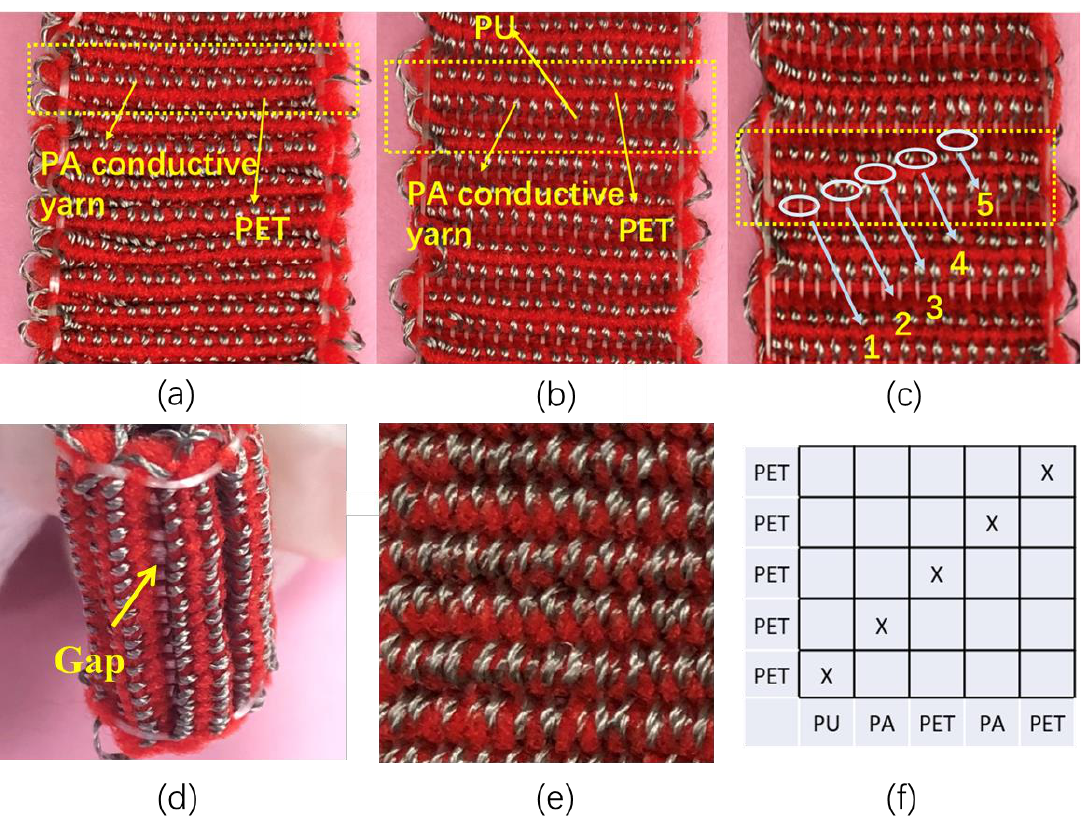
Figure 4. ( a ) The digital photograph of SWF-TENG with twill weave before stretch; ( b , c ) SWF-TENG with twill weave after stretch; ( d ) The side view of SWF-TENG with twill weave; ( e ) The back side of SWF-TENG with twill weave; ( f ) The weave diagram.